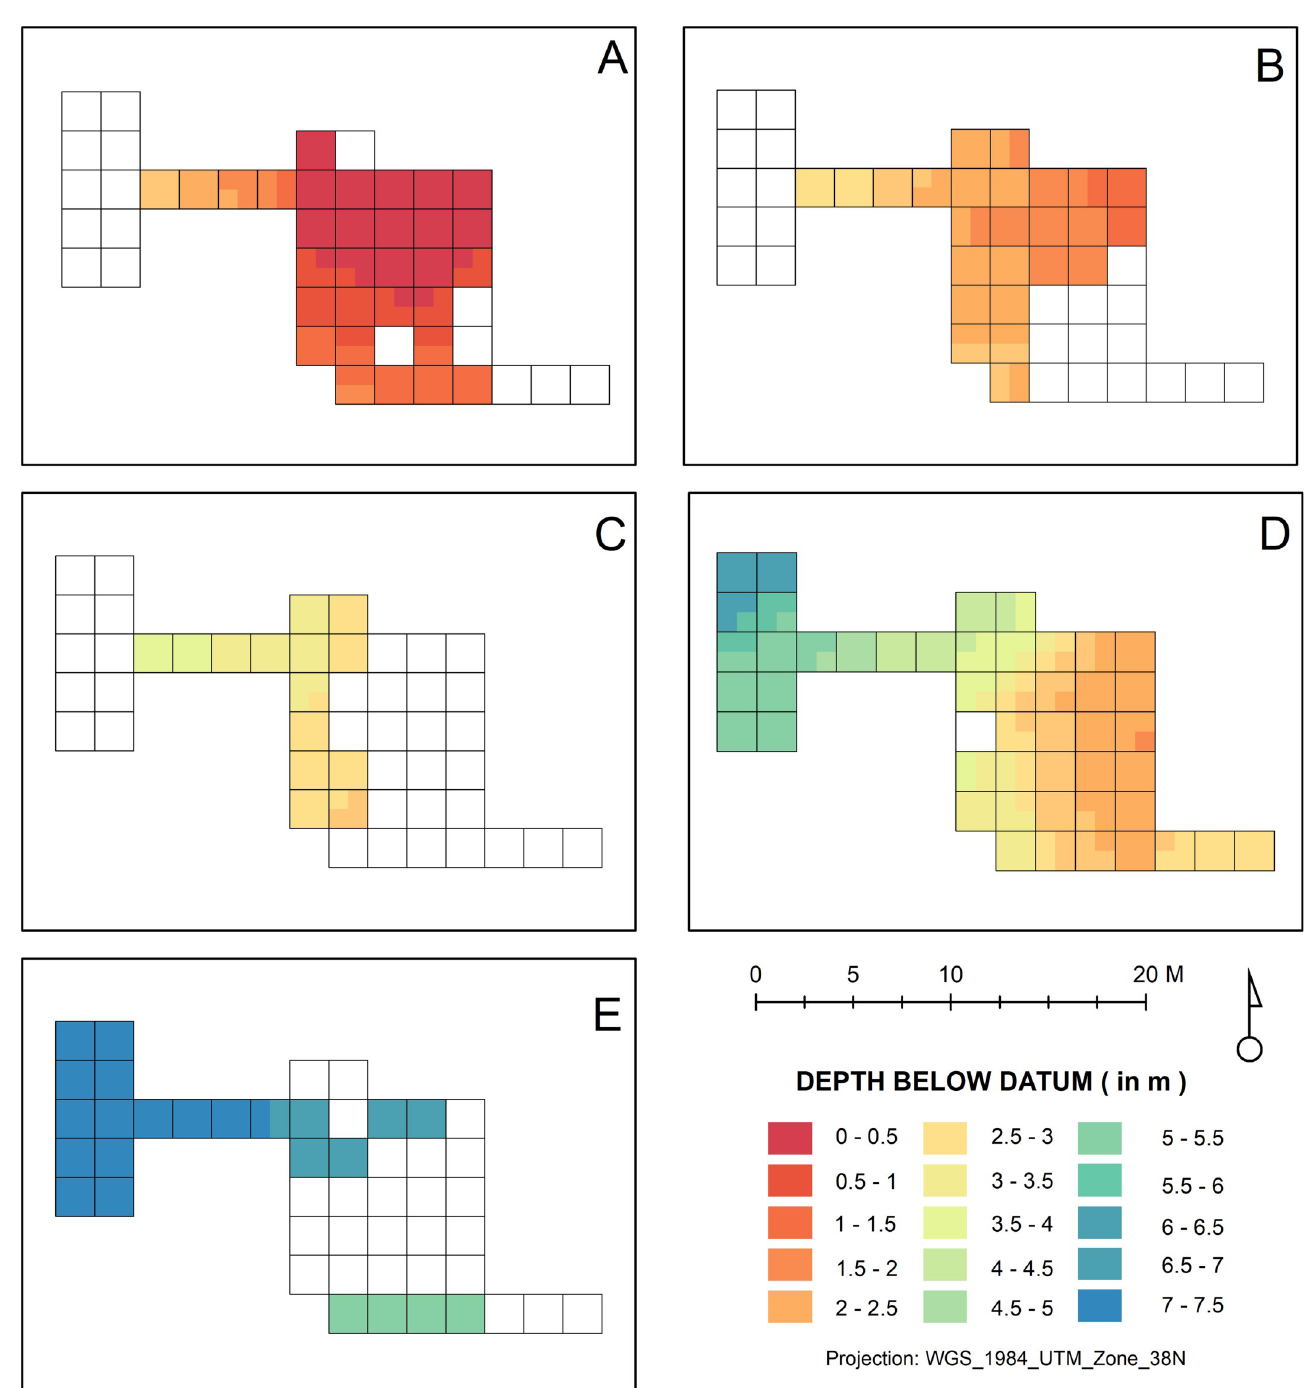
Fig 4. Horizontal extent of Smith’s levels A, B, C, D, and E. Elevation gradient is from warmer (higher elevation) to colder colors (lower elevations), in all